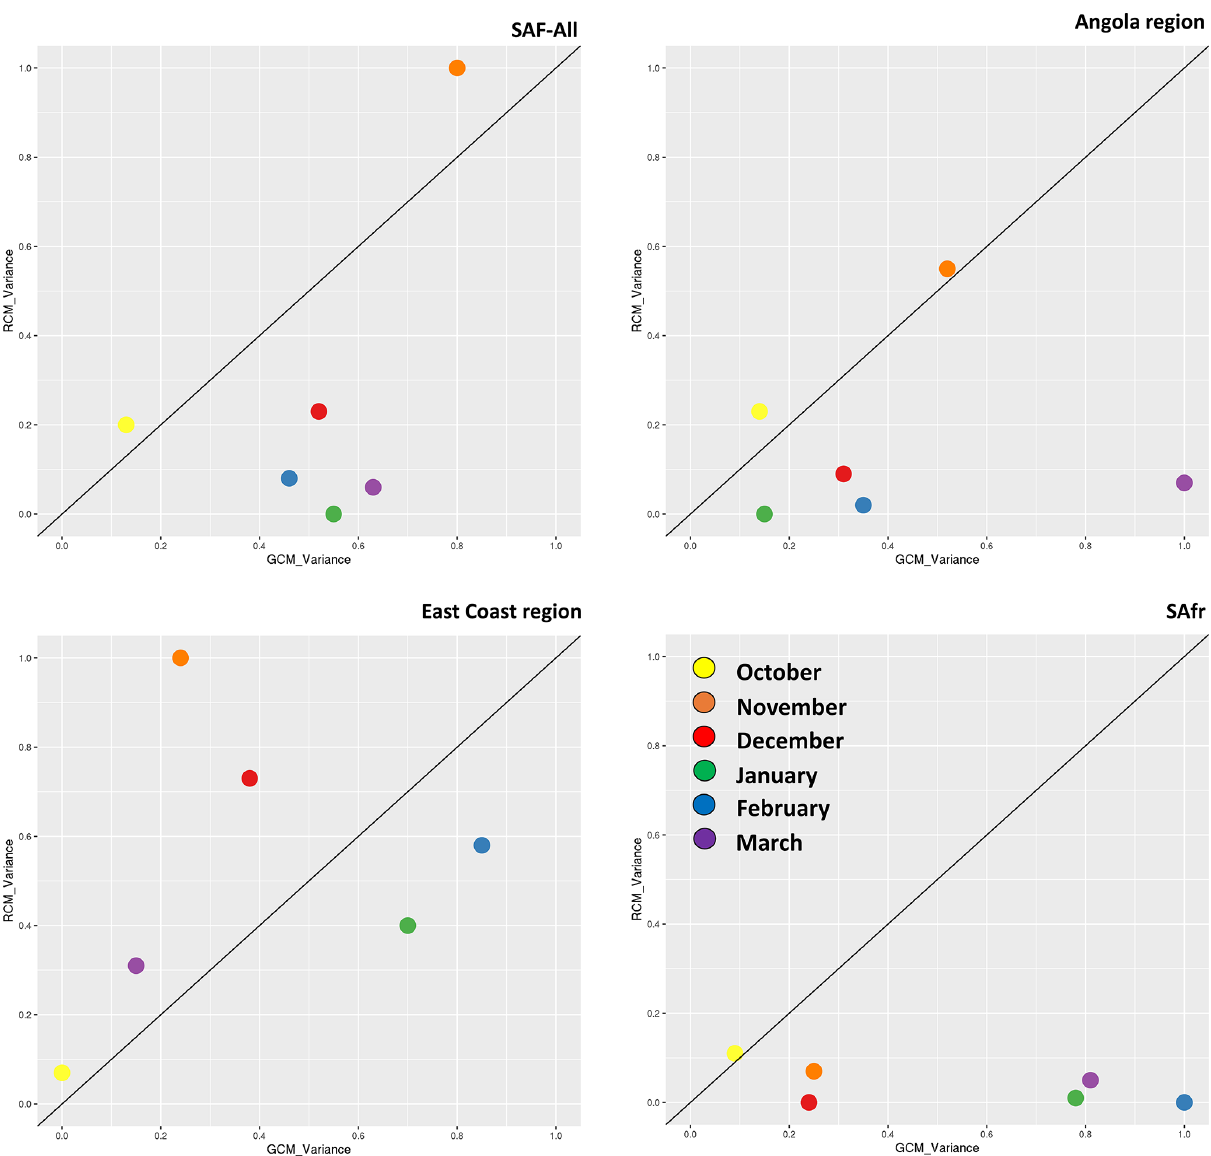
Figure 9. Analysis of variance for monthly precipitation during 1985–2005 for southern Africa (SAF-All region) and the three sub-regions examined, namely the Angola region, East Coast region, and the SAfr region, respectively. The x and y axes display standardized precipitation